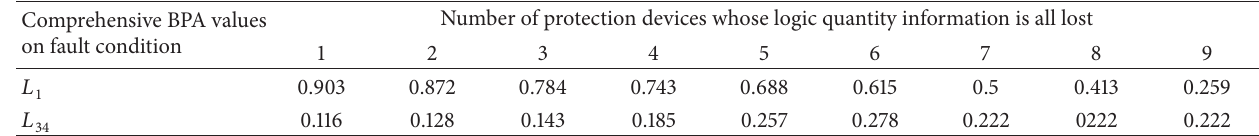
Table 8: WABP performance under condition of information loss when a fault occurs on 𝐿 1 .